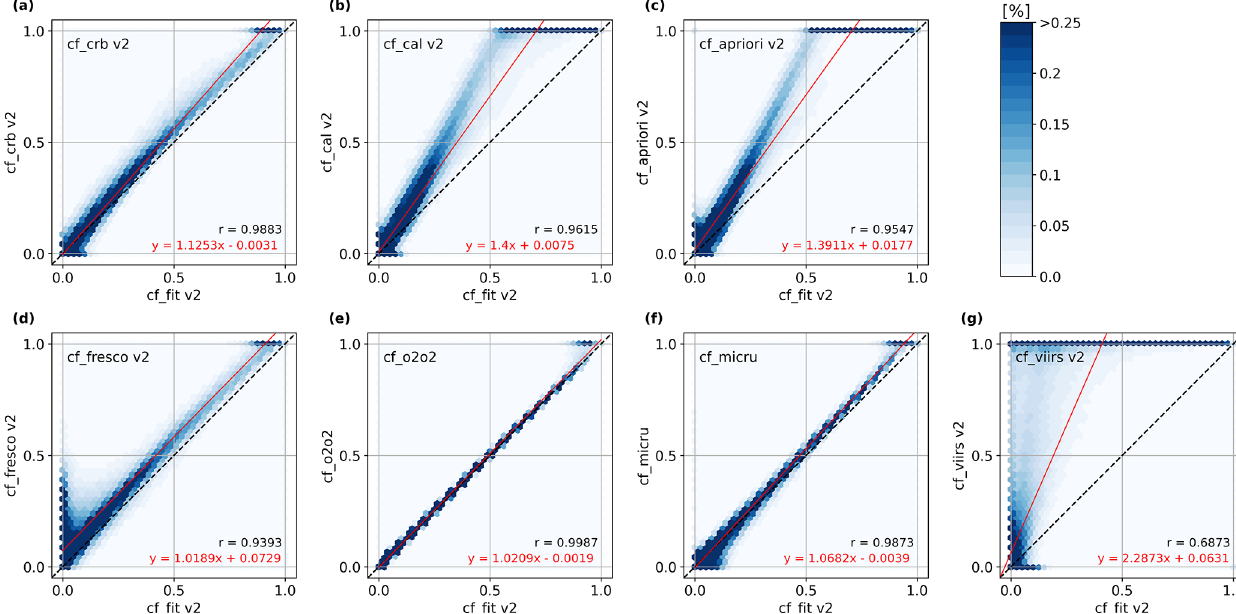
Figure 9. Density histograms between the version 2 cloud fractions from (a) ROCINN CRB, (b) ROCINN CAL, (c) OCRA a priori, (d) FRESCO, (e) O 2 –O 2 , (f) MICRU, and (g) VIIRS and the cloud fraction from the NO 2 fitting window (cf_fit) for Africa and the winter day (5 January 2019).